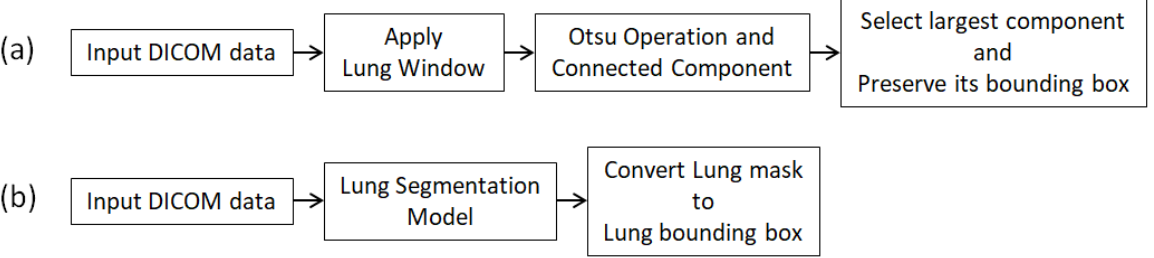
Figure 8. Generating desired ROI. ( a ) Body area; ( b ) Lung fields.